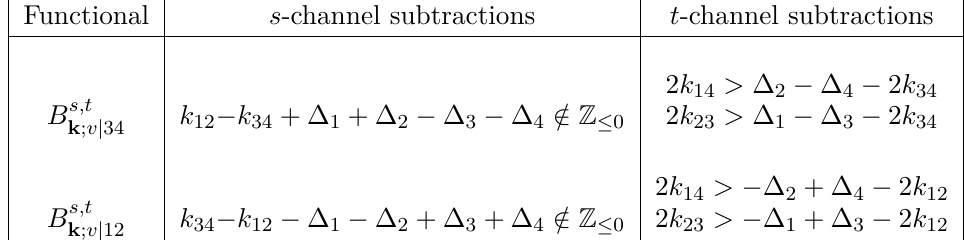
Table 2 . Convergence conditions for non-log functionals determined by subtraction units k ij ∈ Z . s -channel subtractions determine whether the functionals are log or non-log, while t -channel subtractions determine convergence conditions. The t -channel condition becomes eq. (3.36) for the h ABAB i correlator if we consider the G − 1 correlator. Lastly, we note that “anti-subtractions” are possible for k 0 ij <